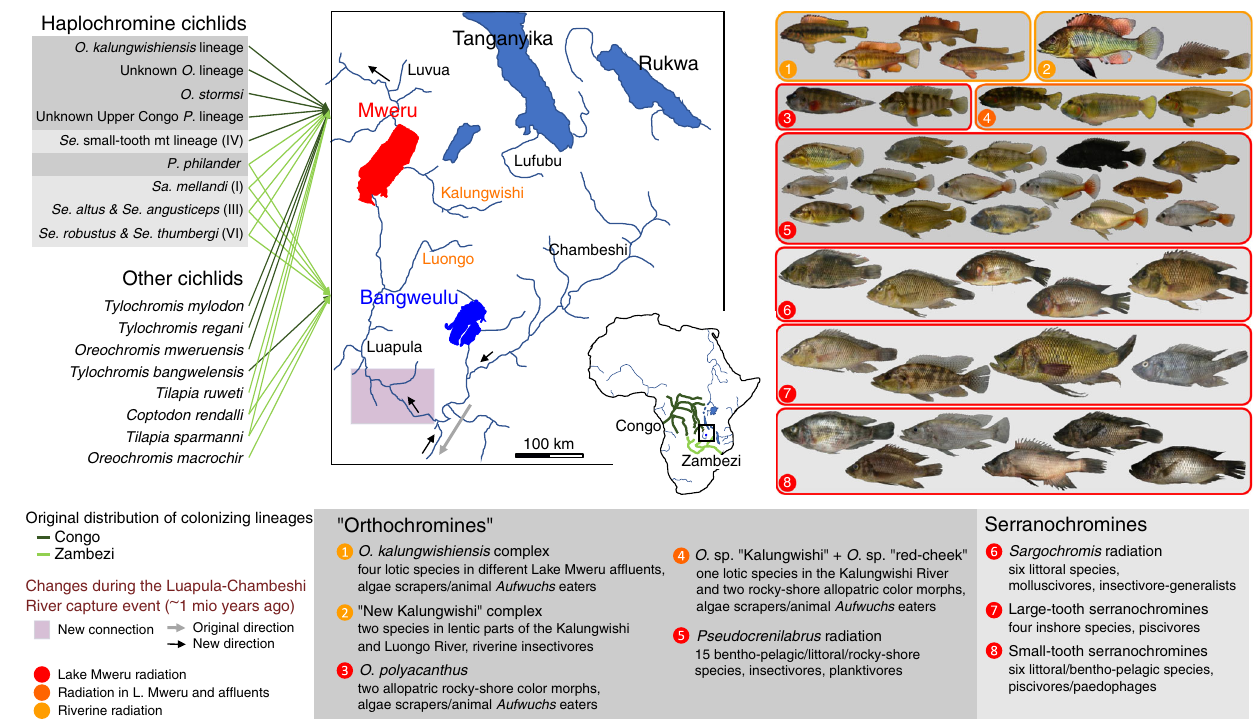
Fig. 1 Geographic setting and cichlid diversity in Lakes Bangweulu and Mweru. Map of the Lake Mweru – Bangweulu region with colonizing lineages of haplochromine cichlids from the genera Serranochromis ( Se .), Sargochromis ( Sa .), Pseudocrenilabrus ( P .) and Orthochromis ( O .), and other cichlids. Lake Mweru has always been part of the Congo catchment (dark green in the inset map of Africa). During the Pleistocene, about 1 million years ago, the Luapula River captured the northeastern arm of the Zambezi catchment (light green), the Chambeshi – Bangweulu system. Lake Mweru was likely colonized by 11 species belonging to nine lineages of haplochromine cichlids. The fi sh photos illustrate the species that evolved from these lineages in radiations restricted to Lake Mweru (red frame) or with species in rivers fl owing into Lake Mweru (orange frame). The number of species and overall ecology of the radiations are listed below. Lake Bangweulu was colonized by six haplochromine species belonging to four lineages, all of which are widespread in the Zambezi and none of them speciated in the lake. Mitochondrial haplotype clade numbers following Joyce et al. 42 are given in parentheses. Both lakes were colonized by non-haplochromine cichlids too (four species in Lake Bangweulu, six in Lake Mweru) but none of these diversi fi ed in the lakes and they are not part of this study. The photos were taken by Ole Seehausen, except for the “ New Kalungwishi ” individuals which were photographed by Hans van Heusden ( fi rst photo) and by Numel Phiri and Cyprian Katongo (second photo), and the four photos of the O. kalungwishiensis complex which were also taken by Hans van Heusden. The species names are given in Supplementary Fig.